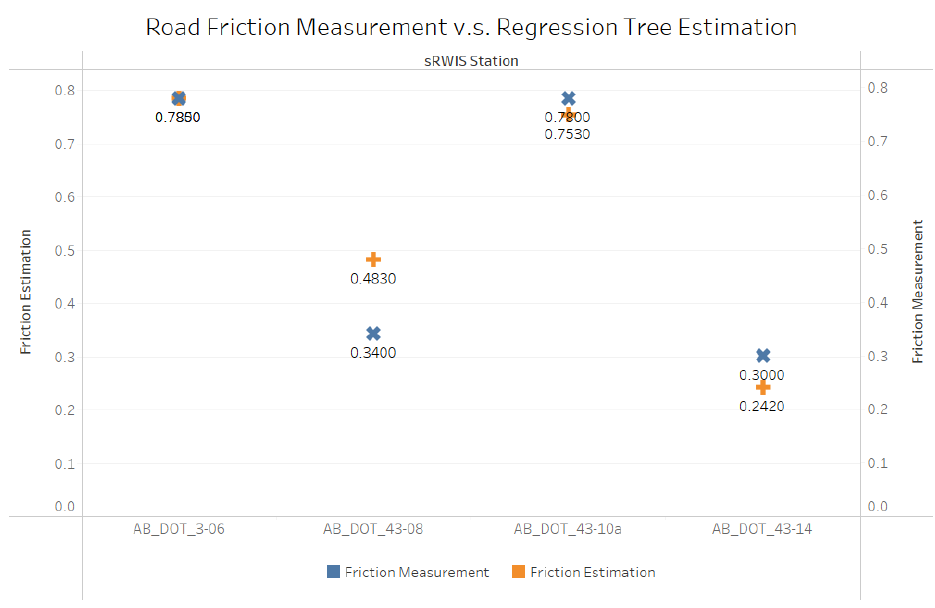
Figure 5. Comparison between road friction measurement and model estimation.